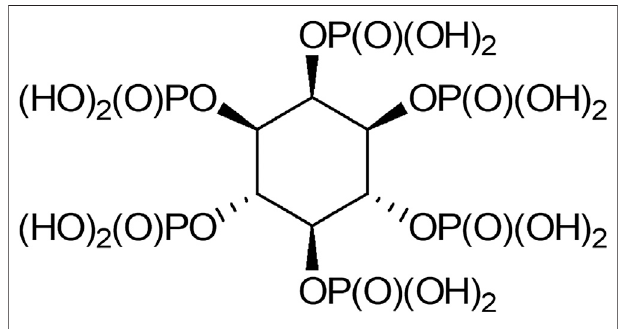
FIGURE 1 | Phytic acid